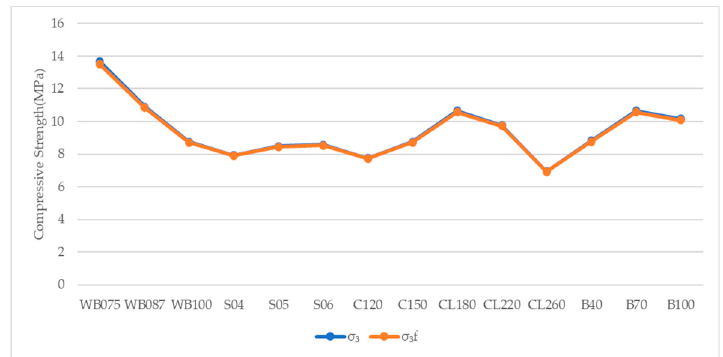
Figure 5. Comparison of Peak Compressive Strength between Calculation and Test with Confining pressure (0.4 MPa, 0.8 MPa).